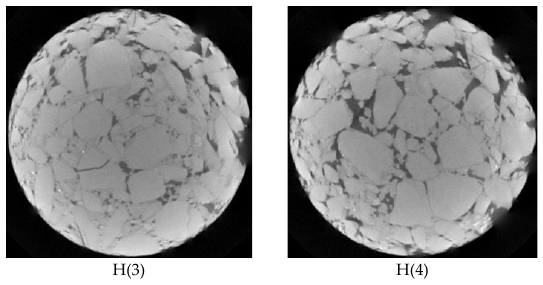
Figure 14. CT images of asphalt mixtures with different segregation degrees. Table 3. Horizontal heterogeneity coefficients of different CT images.